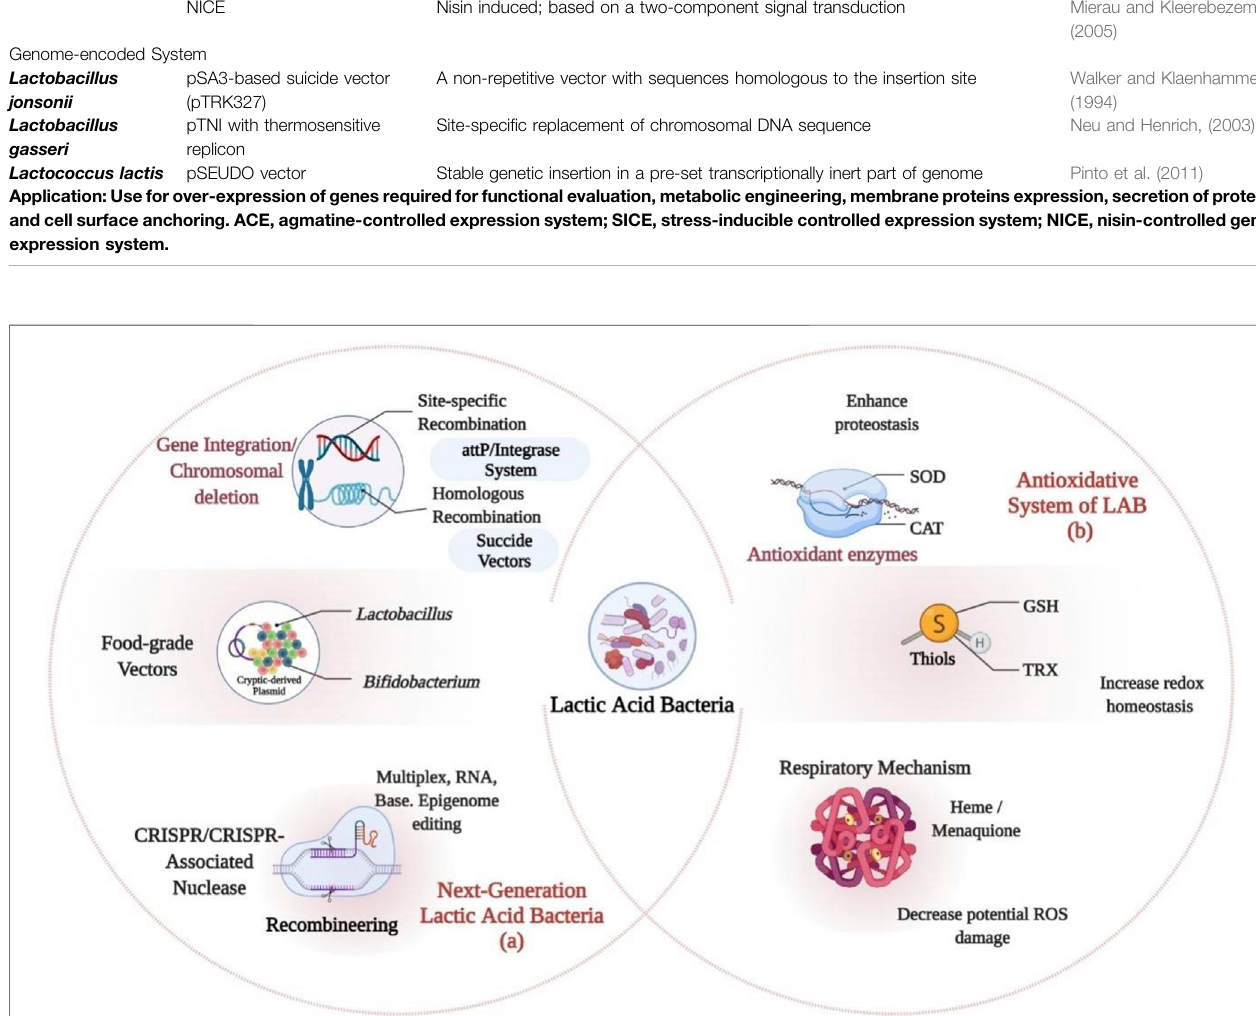
Frontiers in Bioengineering and Biotechnology |